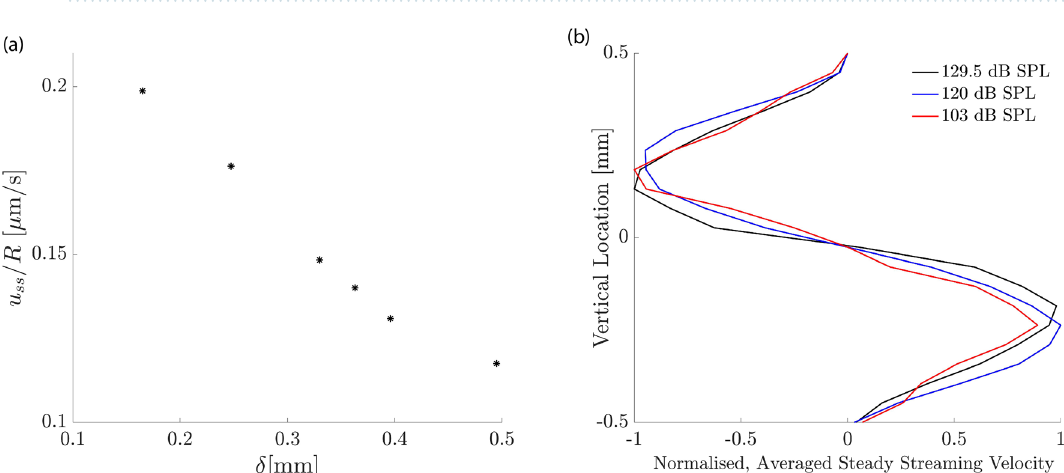
Figure 8. Influence of sound intensity. ( a ) The longitudinal component of the average steady streaming, u ss at the base of the cochlea, normalised by the ratio of the successive frequencies in the multi-frequency stimulation R . If the steady streaming were proportional to the energy dissipated along a constant cochlear extent, then this normalized velocity would be constant. However, the normalized velocity increases strongly for smaller spatial separations, evidencing that the steady streaming becomes stronger when the multi-frequency stimulation uses many pure tones that successively differ only by a small amount. ( b ) Vertical profile of the vertical average steady-streaming velocity 0.1 mm from the base of the cochlea, the basal edge of the circulation region for 170 µ m , as shown in Fig. 6 and its dependence on the sound intensity. The stimulation intensity has only δ = little influence on the velocity profile. The velocity profiles have been normalized by the maximal value at each sound pressure to investigate the most effective way to harness the streaming. The aim of the work was to determine whether there is a combination of tones which could deliver (or at least better redistribute) a drug which has either dif- fused across the round window or been injected through it directly. Each pure tone resulted in an eddy in each cochlear chamber whose apical edge caused particle translation back towards the base of the cochlea. Playing a single tone therefore serves to rotate the particles locally in the